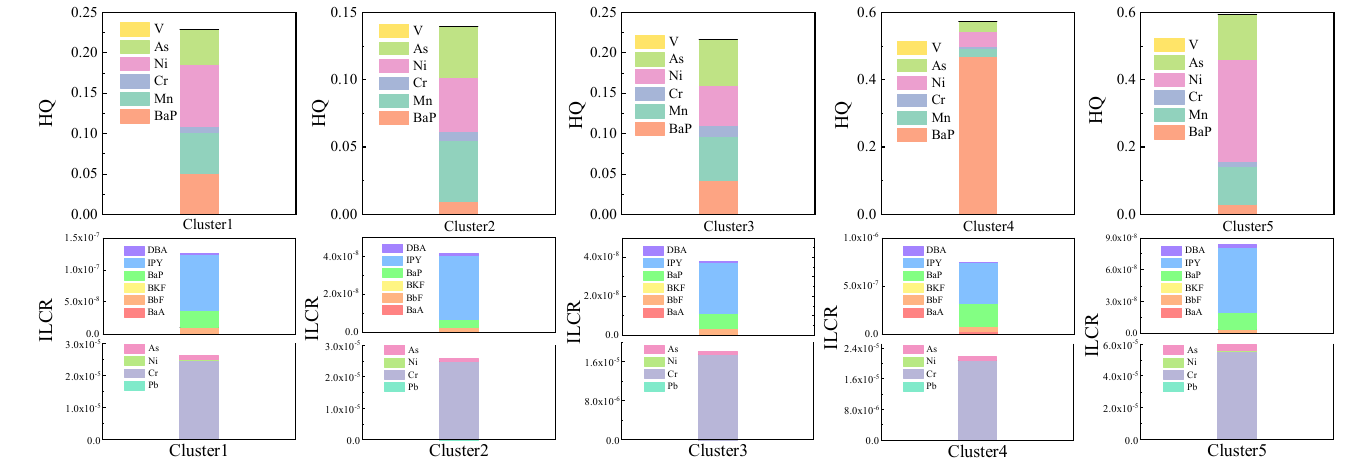
Figure 5. The HQ (non-cancer risk) and ILCR (cancer risk) for each cluster from diverse regions to PM 2.5 in TI.